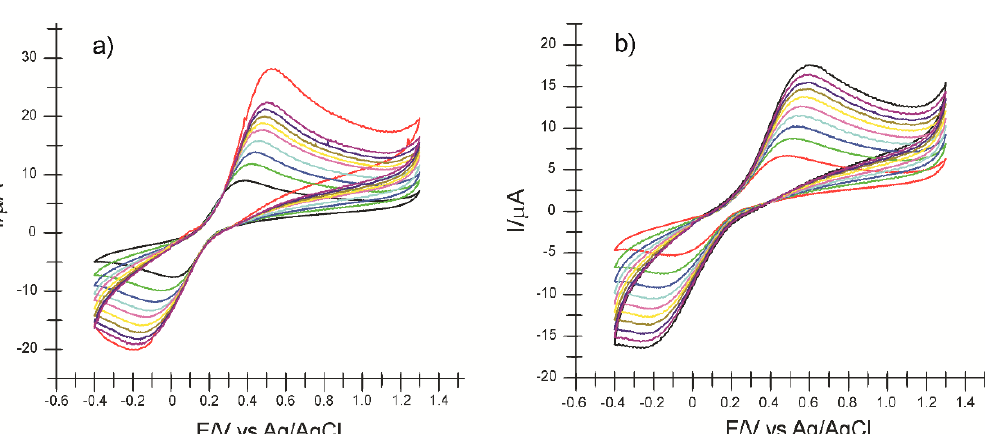
Figure 4. Cyclic voltammograms of CNF-CoPc/SPE ( a ), CNF-CoPc-Lac/SPE ( b ) immersed in 10 − 3 M K 4 [Fe(CN) 6 ]—0.1 M